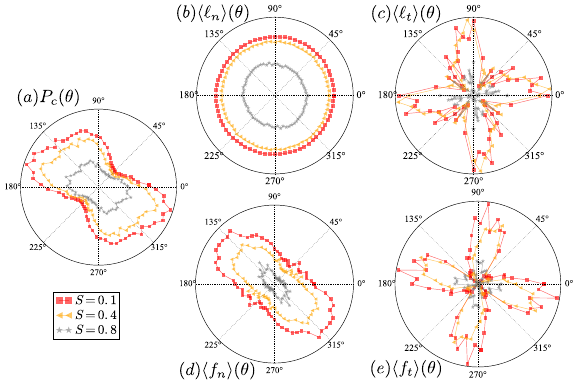
Figure 3. Angular distribution of (a) contact orientations, (b) normal force and (c) tangential force intensities, and (d) normal branch and (e) tangential branch components for di ↵ erent values of S at the steady state.